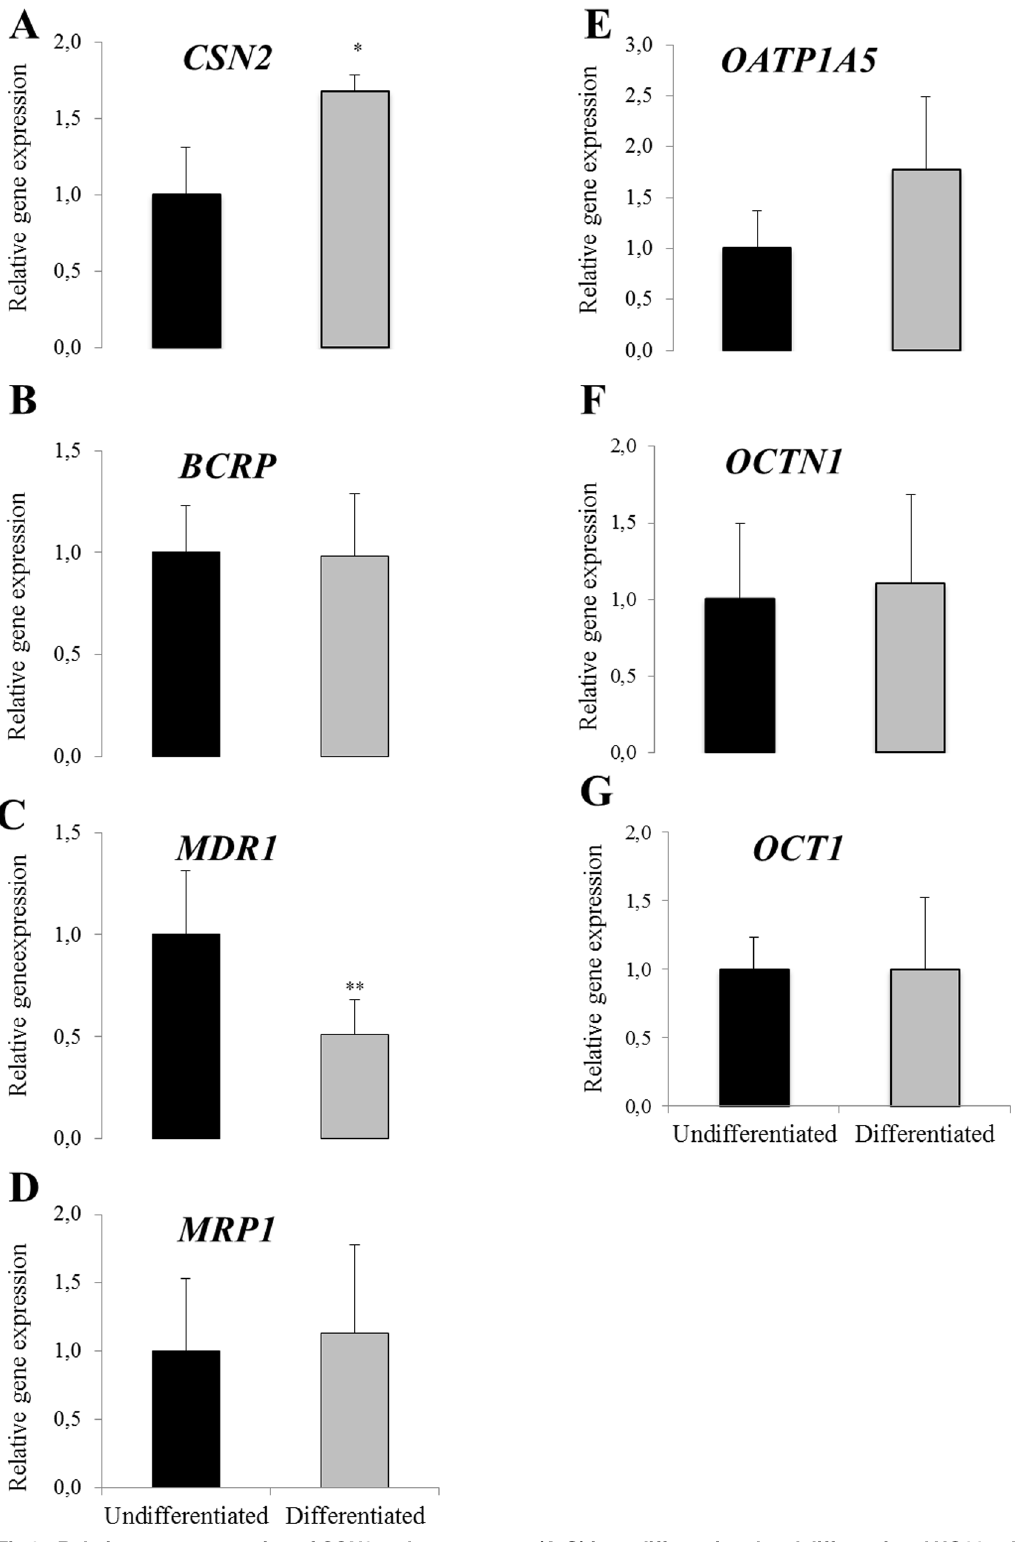
Fig 2. Relative gene expression of CSN2 and transporters (A-G) in undifferentiated and differentiated HC11 cells . Normalized gene expressions (A-G) are presented as means ± SD; n = 6 pooled from 2 separate experiments. Statistically significant differences as compared to undifferentiated controls * p (cid:1) 0.05; ** p (cid:1) 0.01. doi:10.1371/journal.pone.0151904.g002 PLOS ONE | DOI:10.1371/journal.pone.0151904 March 30,